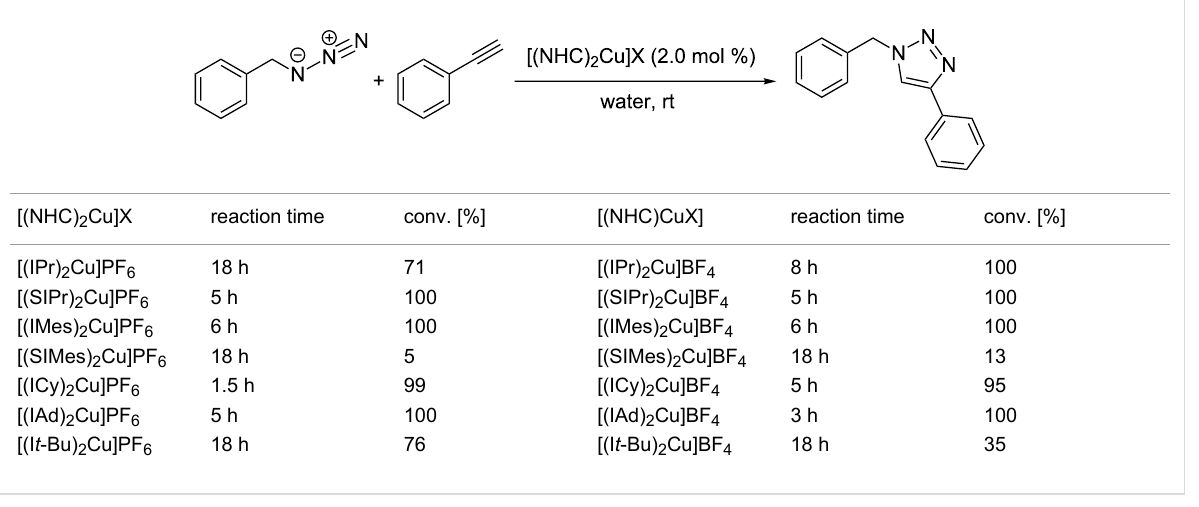
Table 4: Application of [(ICy) 2 Cu]PF 6 in different organic solvents, water and under neat conditions [153].